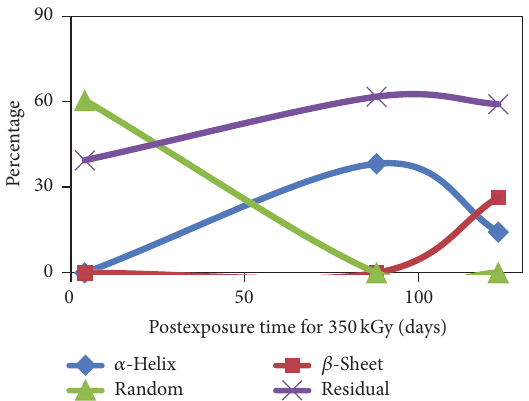
Figure 10: Variations of conformation in the wool secondary structure with absorbed dose and postirradiation